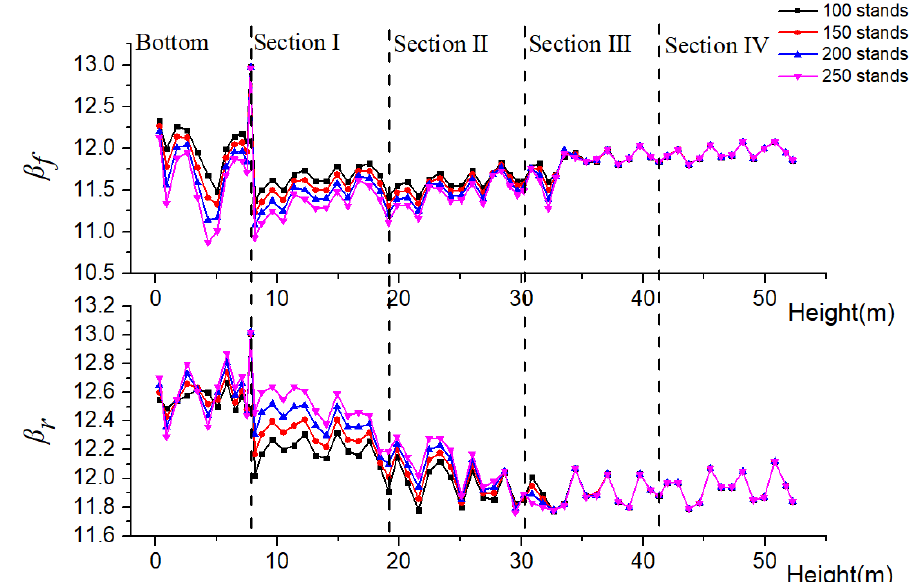
Figure 8. Variation curve of column reliability index along with height under different number of stands.